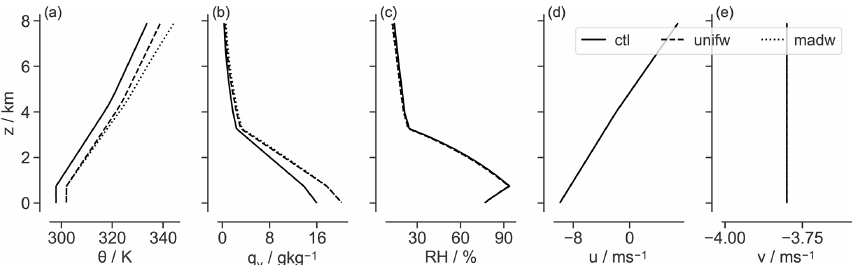
Figure 1. Initial profiles of (a) potential temperature θ , (b) specific humidity q v , (c) relative humidity (RH), (d–e) horizontal winds u and v for the control (solid line) and the perturbed (vertically uniform warming, dashed line; warming following a moist adiabat, dotted line) climate